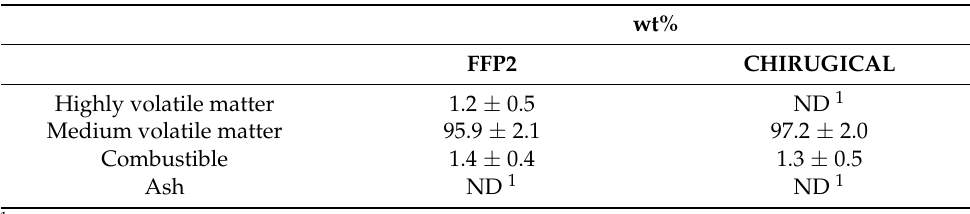
Table 3. Proximate and compositional analyses of FFP2 and chirurgical masks as received (ASTM E1131-20: average value of three tests ± standard deviation) [34].